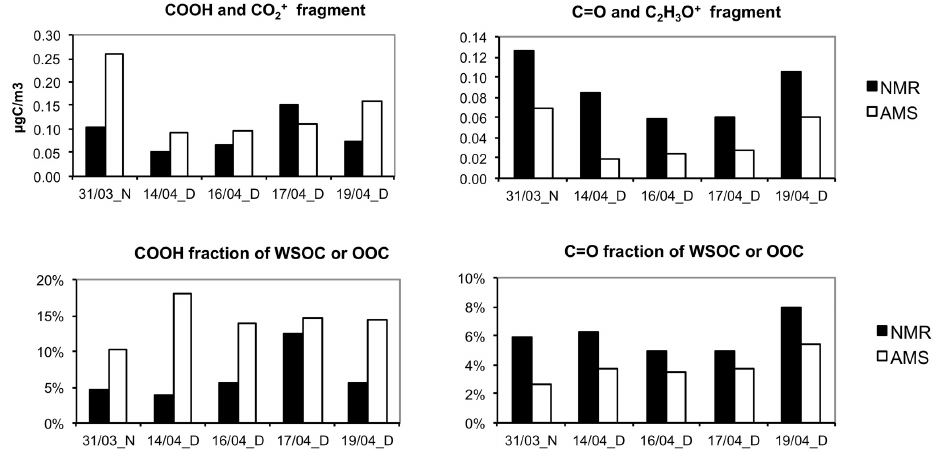
Figure 4. Concentration of carboxylic acids and carbonyls determined by chemical derivatization – 1 H-NMR analysis in five PM1 WSOC samples. Time-averaged concentrations of the CO + and C 2 H 3 O + fragments from HR-TOF-AMS measurements are also reported as proxies 2 for acid and non-acid oxygenated functional groups, respectively. For more details refer to the text.